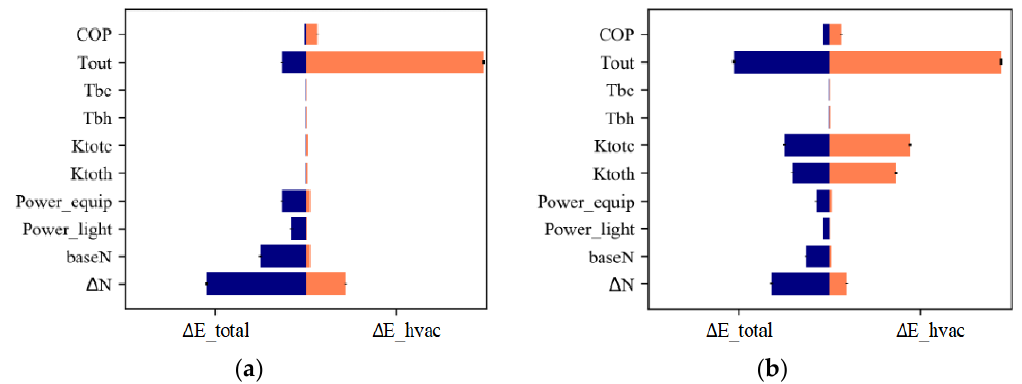
Figure 12. Total effect indices for the main inputs on ∆E total and ∆E hvac in two different scenarios: ( a ) occupants can change K tot and ( b ) occupants cannot change K tot .